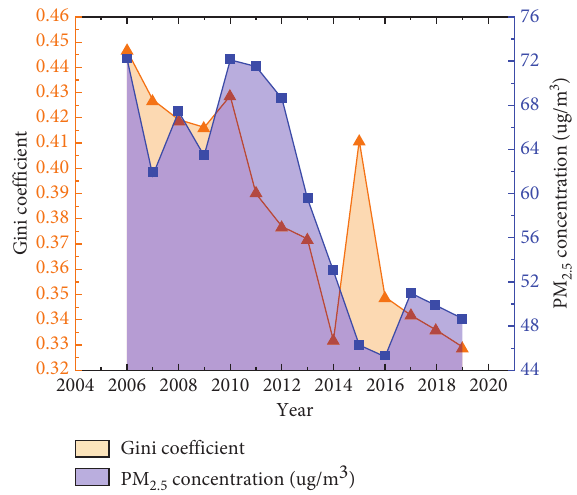
Figure 11: The Gini coefficient and the PM